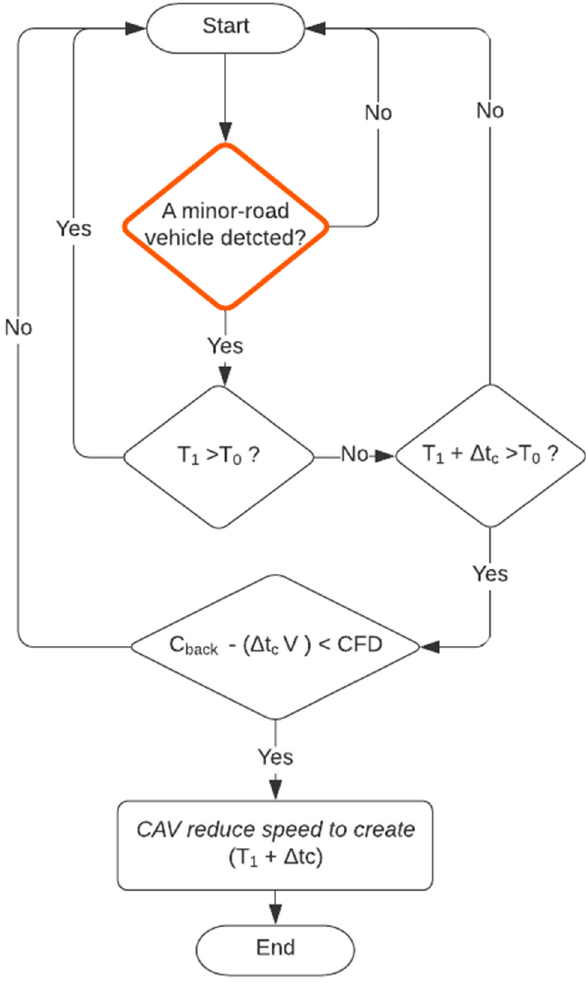
Figure 7: Control logic for a right - turning vehicle in mixed tra ffi c fl